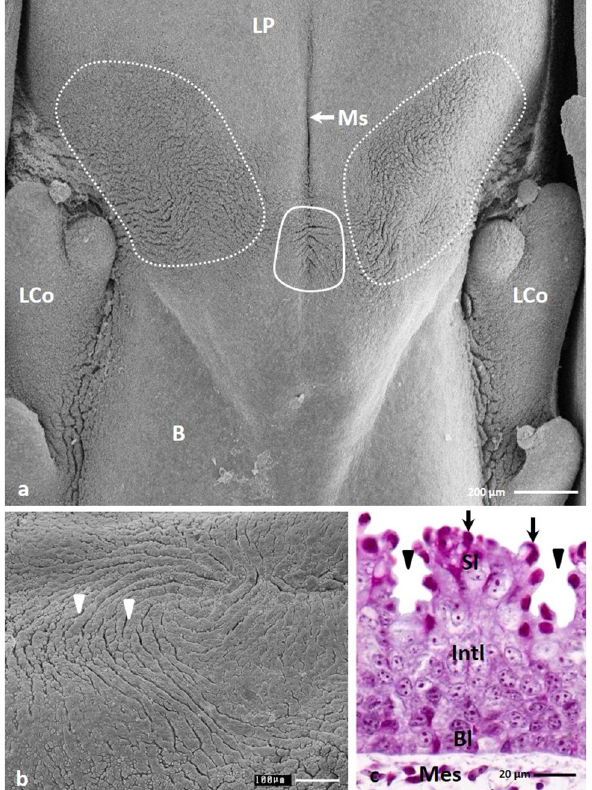
Figure 4. ( a ) 17th day of incubation. View on the surface of the lingual prominence with parallel arranged furrows (continuous line) on the sides of the anterior part of the median sulcus (Ms). The lateral areas with epithelial furrows (dotted lines) extend from the anterior edges towards the medial part of the lingual prominence (LP). B-body of the tongue, LCo-large conical papillae. SEM. ( b ) 17th day of incubation. Higher magnification of the lateral area of the lingual prominence with wavy arrange furrows (arrow heads). SEM. ( c ) 18th day of incubation. Cross section of the epithelium of the lingual prominence with superficial furrows (arrow heads). The arrows show the condensed cell nuclei in cells of the superficial layer. Bl-basal layer, Int- intermediate layer, Mes-mesenchyme, Sl-superficial layer. LM. Masson–Goldner